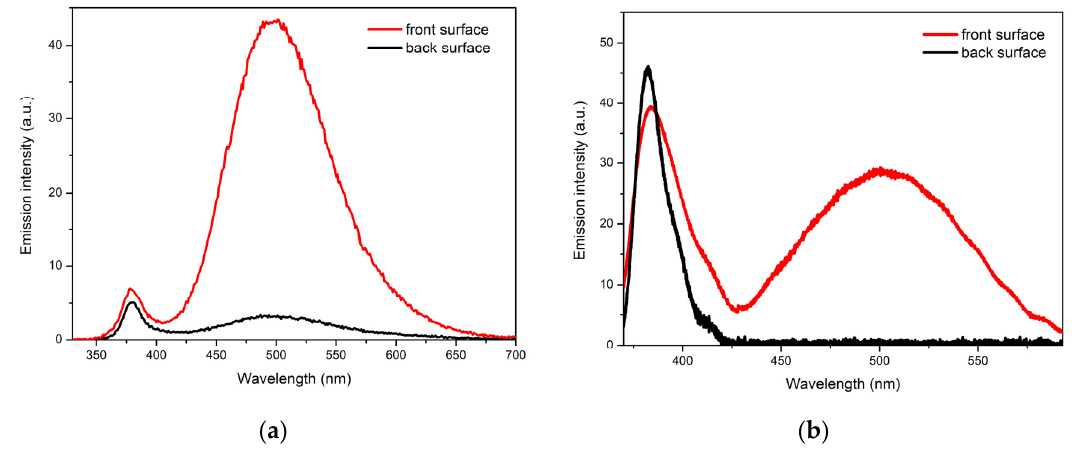
Figure 8. PL spectra of the front (red) and back (black) surfaces of the N1 film under: ( a ) low-intensity excitation and ( b ) pulsed laser excitation.